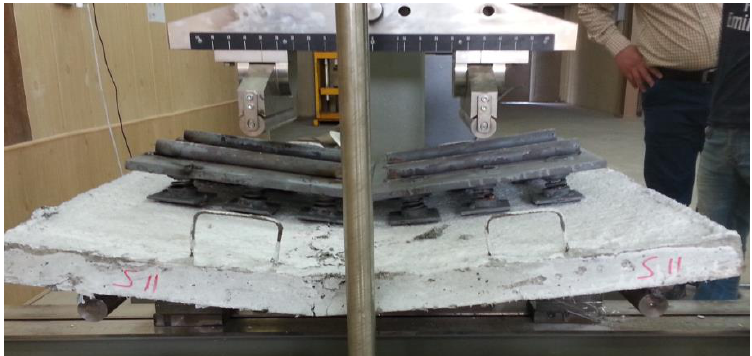
Figure 11. Ductile failure of slap PVC-60.